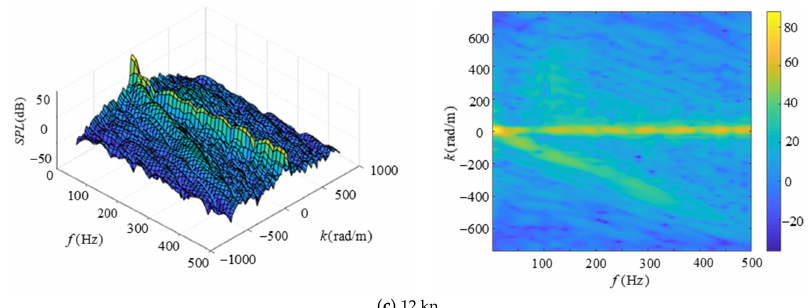
Figure 19. Two views of the wave-number frequency spectrum at different velocities. Table 6 lists the computed results for the wave-number frequency spectrum parameters. The three velocities had peak spectral levels of 21.79 dB, 64.61 dB, and 83.57 dB, respectively. These values are consistent with the change in the self-power spectral level, which rises with increasing velocity. The migration velocity is one of the crucial physical quantities to examine the turbulent wall pressure, which reflects the motion velocity of the turbulent vortex cluster structure. The calculated migration velocities for 5.93 kn, 10 kn, and 12 kn were 2.17 m/s, 3.62 m/s, and 4.49 m/s, respectively, while the corresponding dimensionless velocities were